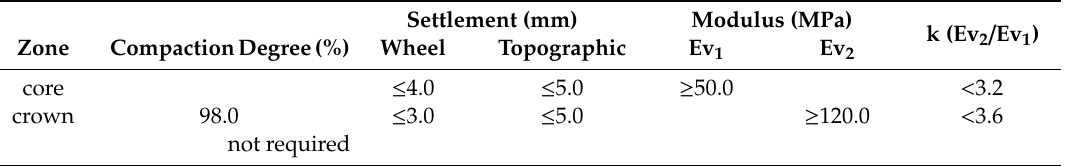
Table 2. Specifications suggested for